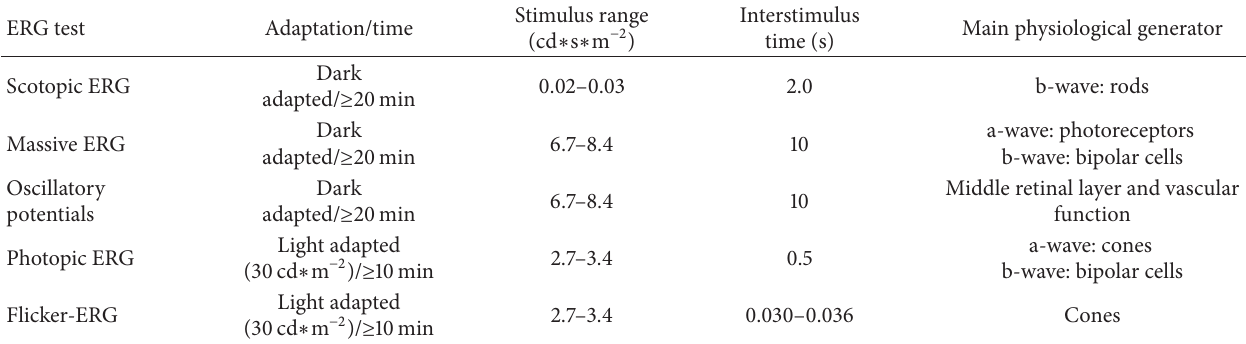
Table 1: Standard full field ERG protocols and parameters according to